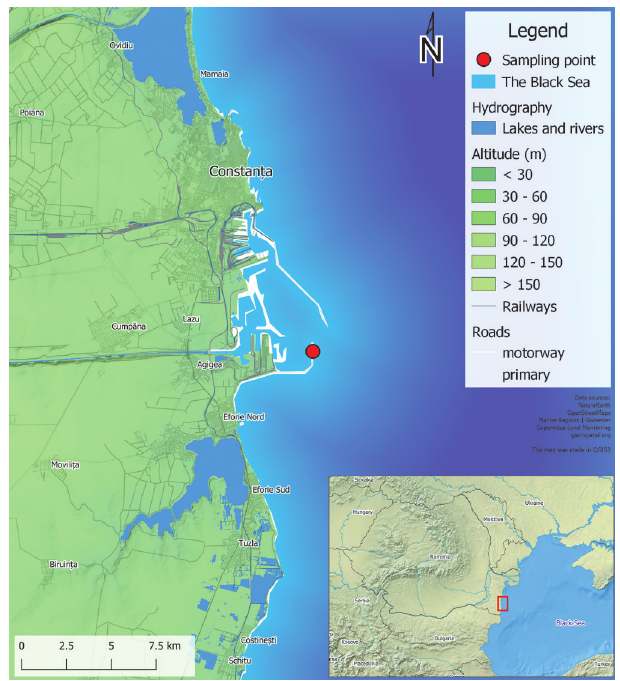
Figure 1 . The location of the new Magallana gigas population at the Romanian Black Sea coast is in- dicated by the red